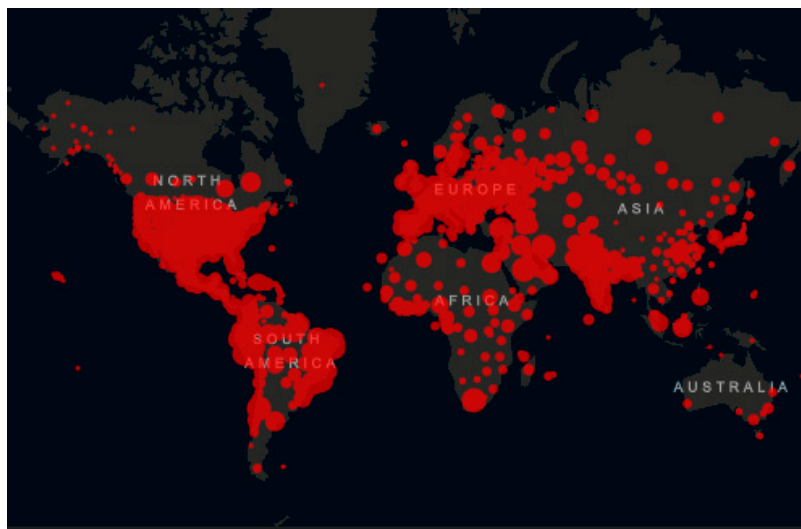
Figure 1. Distribution map of the virus worldwide as of 1 July.